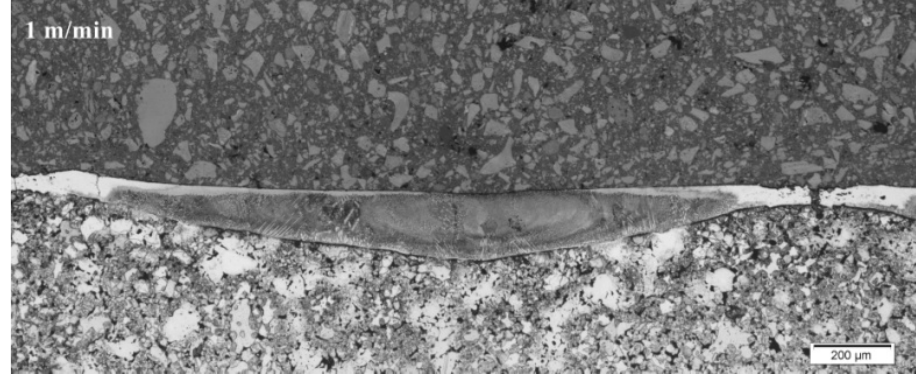
Figure 7. Cross-section of the entire alloyed zone for sample 1.